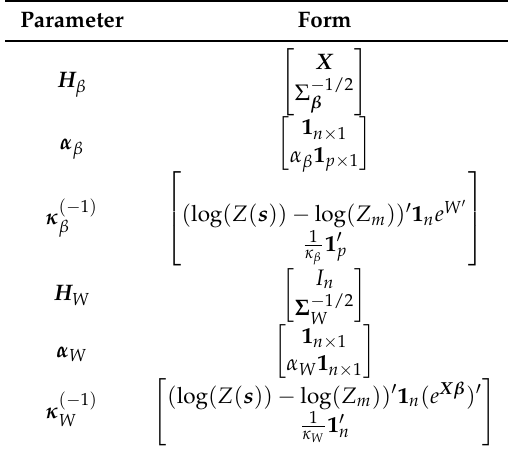
Table A1. Parameters of the full conditional distribution.